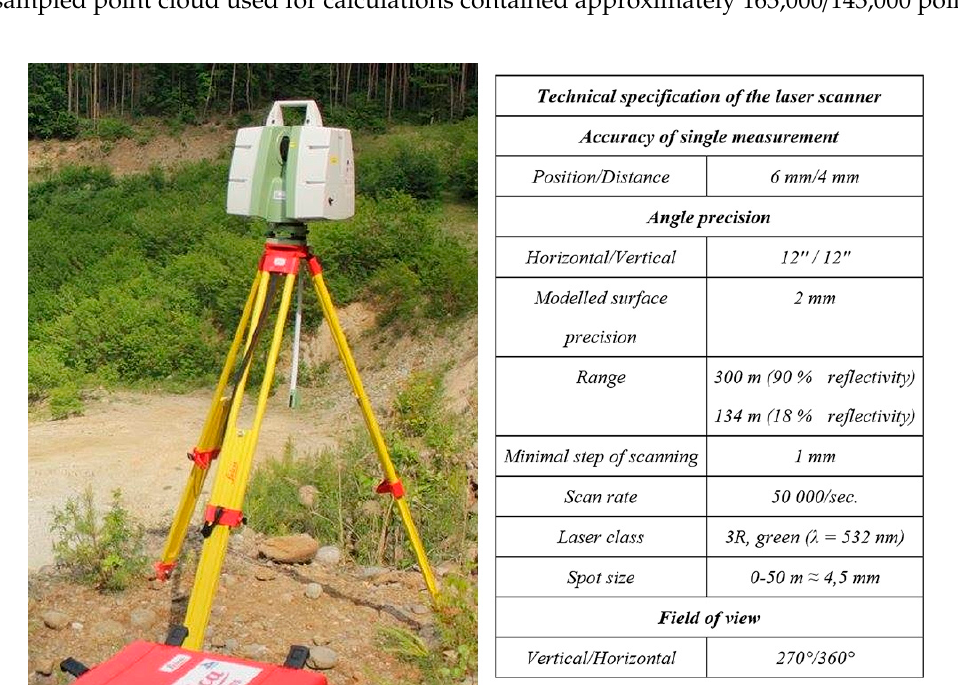
Figure 8. Terrestrial laser scanner Leca ScanStation C10 over a survey station. Minerals 2020 , 10 , 174